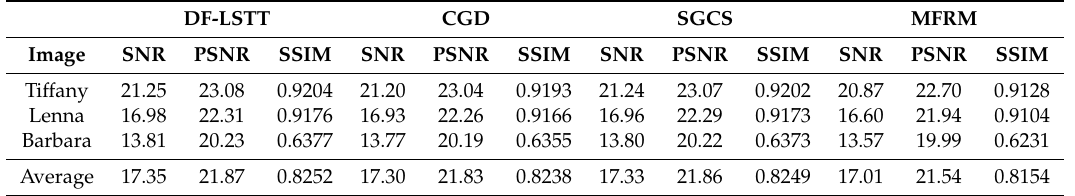
Table 2. Numerical results of DF-LSTT, CGD, SGCS, and MFRM methods in image